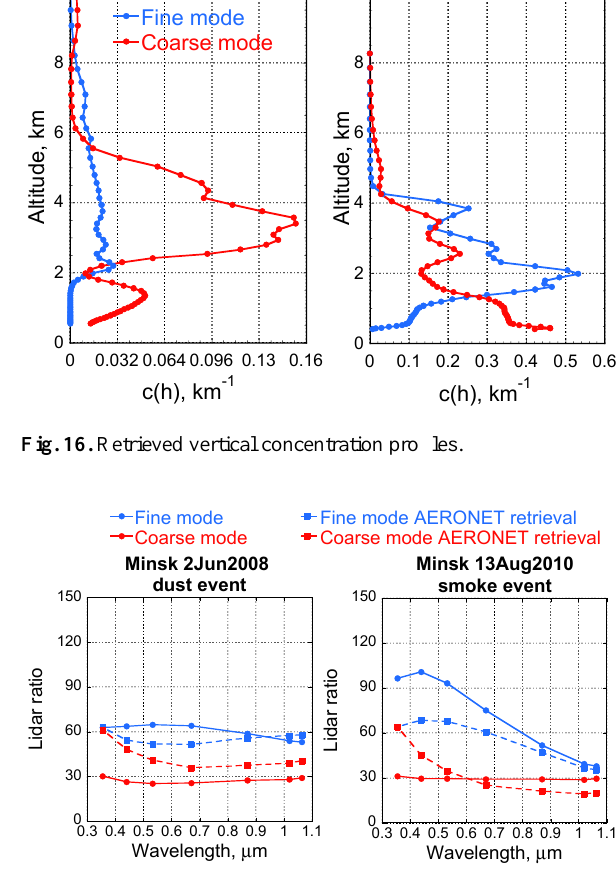
Fig. 17. Retrieved aerosol lidar